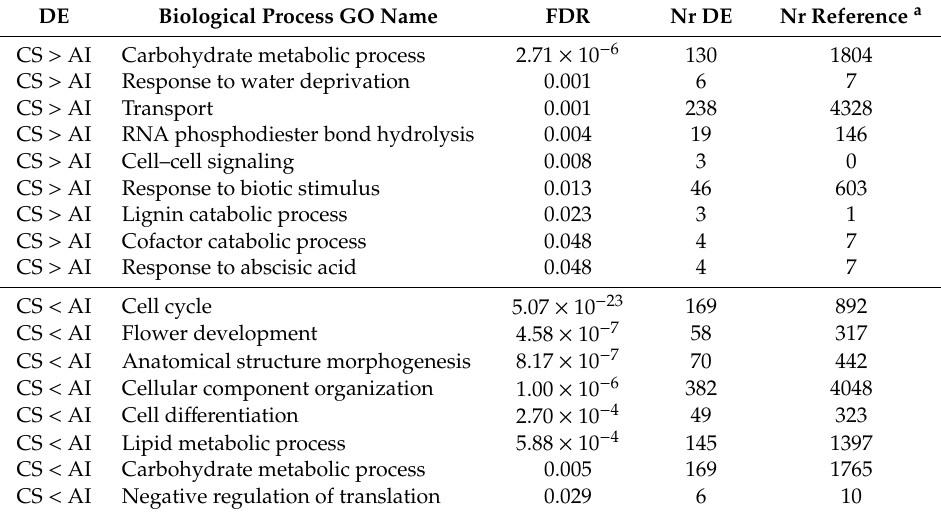
Table 10. Over-represented plant gene ontology (GO) biological process categories of di ff erentially expressed (DE) plant transcripts in choke stroma tissue (CS) and asymptomatic inflorescence (AI) using Fisher’s Exact Text at false discovery rate (FDR) < 0.05 in Blast2GO. Only the most specific GO categories are